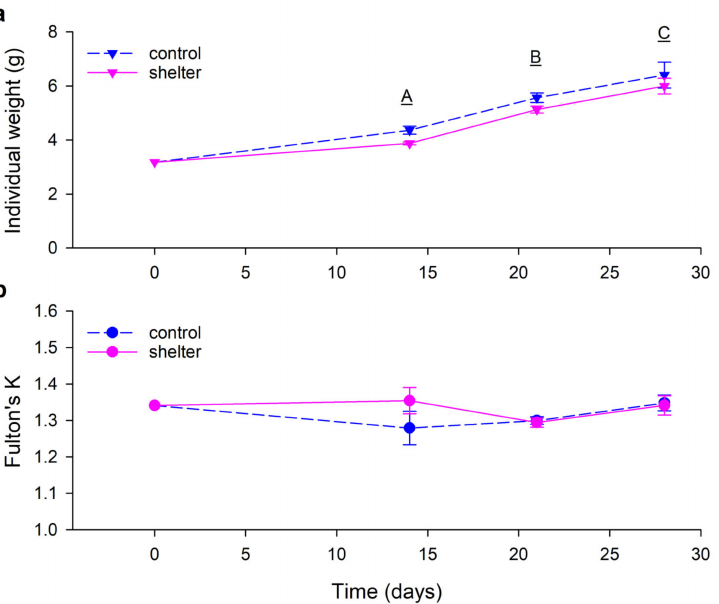
Figure 3. Individual mass (panel a) and Fulton’s condition factor (K, panel b) of rainbow trout ( Oncorhynchus mykiss ) fingerlings in Control and Shelter groups during the experimental period. Data represent the mean and SEM of n = 3 tanks per treatment. ( a ) Individual weight was affected by time ( p < 0.001, different letters in the graph indicate significant differences among sampling times), but not by treatment ( p = 0.067) or by the interaction time × treatment ( p = 0.707). ( b ) Neither treatment ( p = 0.104) nor time ( p = 0.407) or their interaction ( p = 0.424) affected K (two-way repeated measures ANOVA). No measurements were taken on day 7 due to technical failure of the weighing equipment.